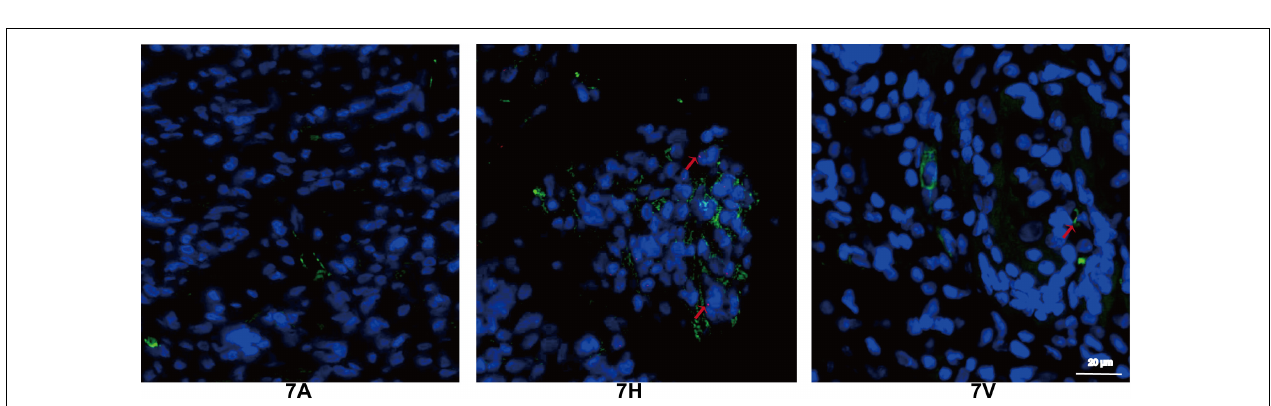
FIGURE 8 | CD34 expression in regenerative tissue detected and analyzed by immunohistochemistry. (A) Microscopic morphology of regenerative tissue (Scale bar = 50 µ m). Stars indicate PP mesh fibers. Black arrows indicate vessel lumen and CD34 expression in regenerative tissue. Red arrows indicate foreign body giant cells in regenerative tissue. (B) IOD was used to analyze the expression of CD34. * P < 0.05 vs. the PP, PLA, 1:7, 7A, and 7C groups.